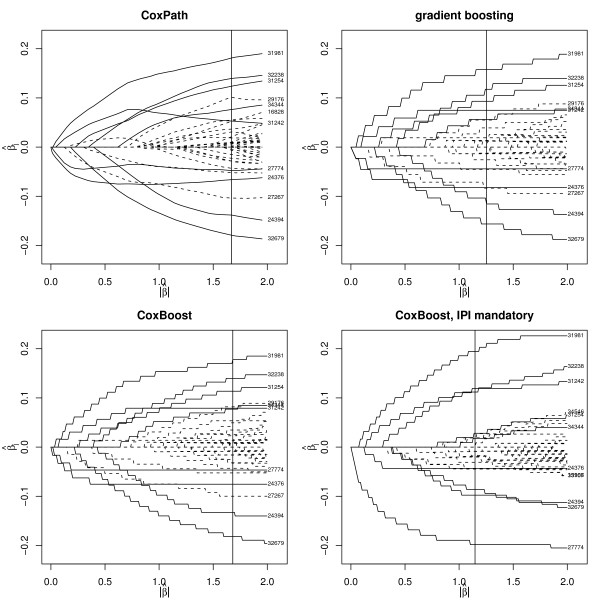
Coefficient paths for CoxBoost. Estimated parameters plotted against the norm of the parameter vector for CoxPath (top left), gradient boosting (top right), componentwise CoxBoost (bottom left), and CoxBoost with a mandatory covariate (bottom right). CoxPath steps and boosting steps selected by cross-validation are indicated by vertical lines. Covariates selected by all approaches up to this number of steps are indicated by solid curves, the others by dashed curves. For them and other strong covariates the UNIQID is given.